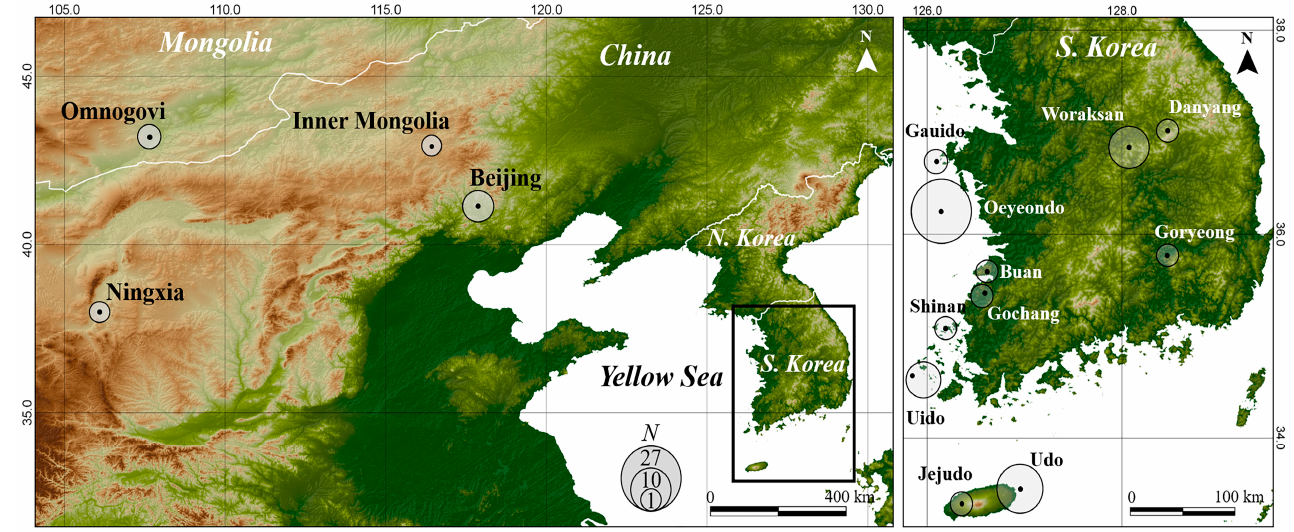
Figure 1. Sampling locations of Orientocoluber spinalis across South Korea, China, and Mongolia.